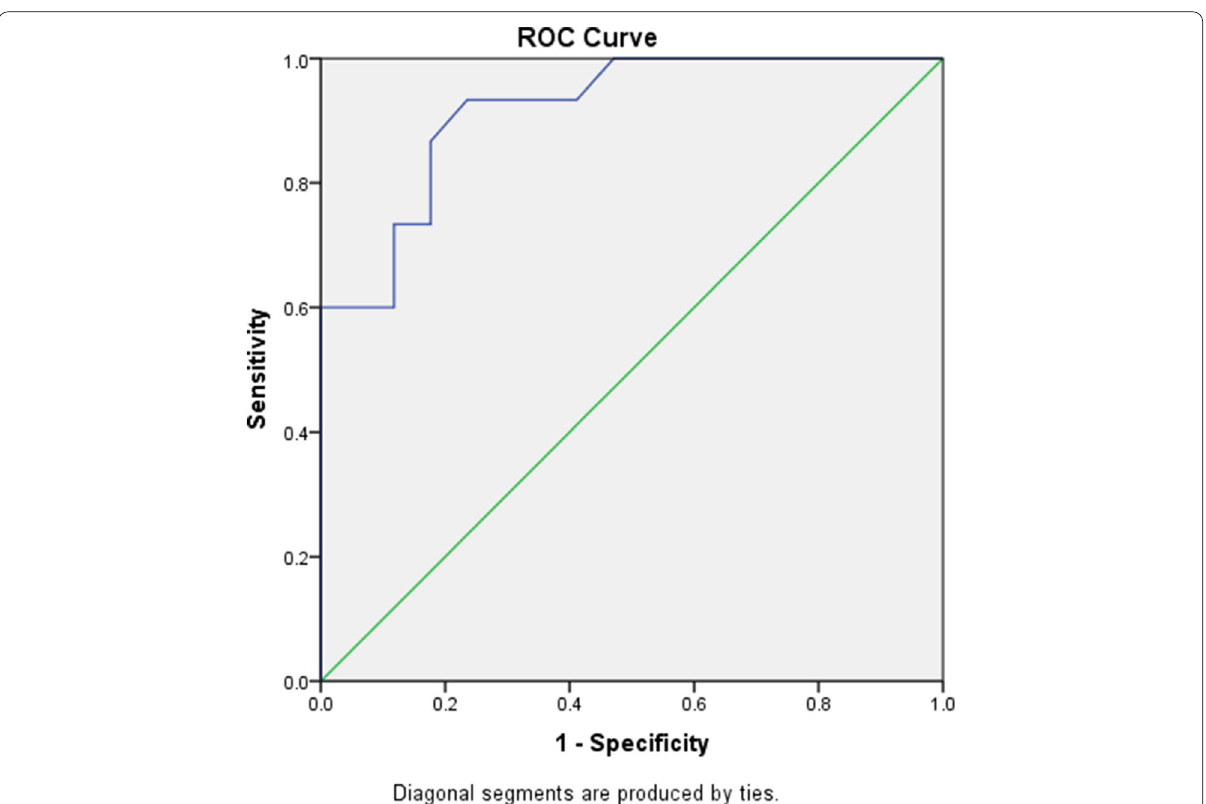
Fig. 1 ROC curve for prediction of metabolic syndrome in premenopausal women. ROC curve for prediction of metabolic syndrome in premenopausal women using cutoff value of 5.8 ng/ml for hepcidin. The AUC, sensitivity, and specificity were 0.910, 93.3%, 76.5% respectively ≥ with p values ≤